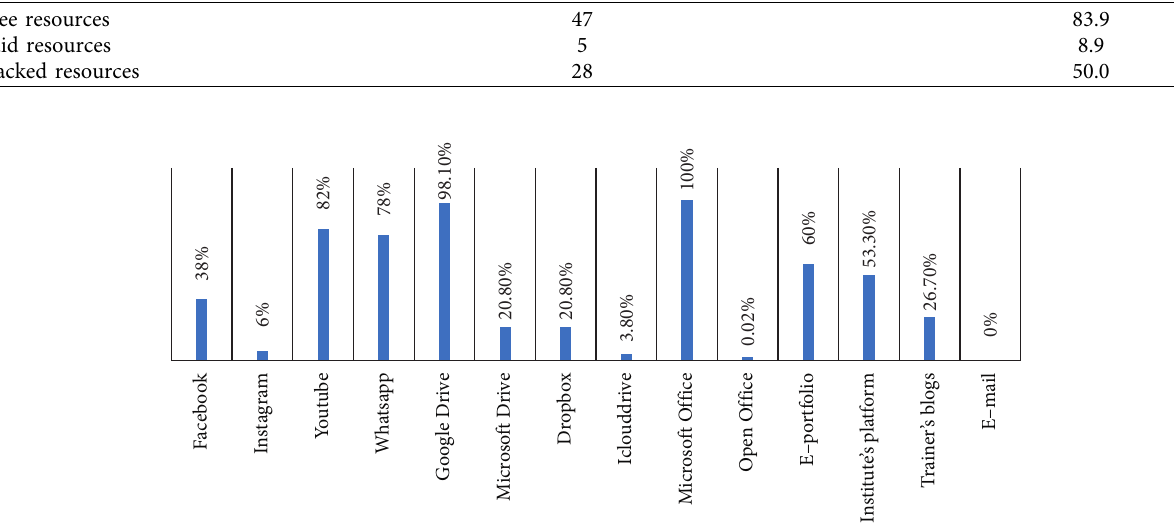
Figure 1: The different digital tools used during the individual preparation of content.